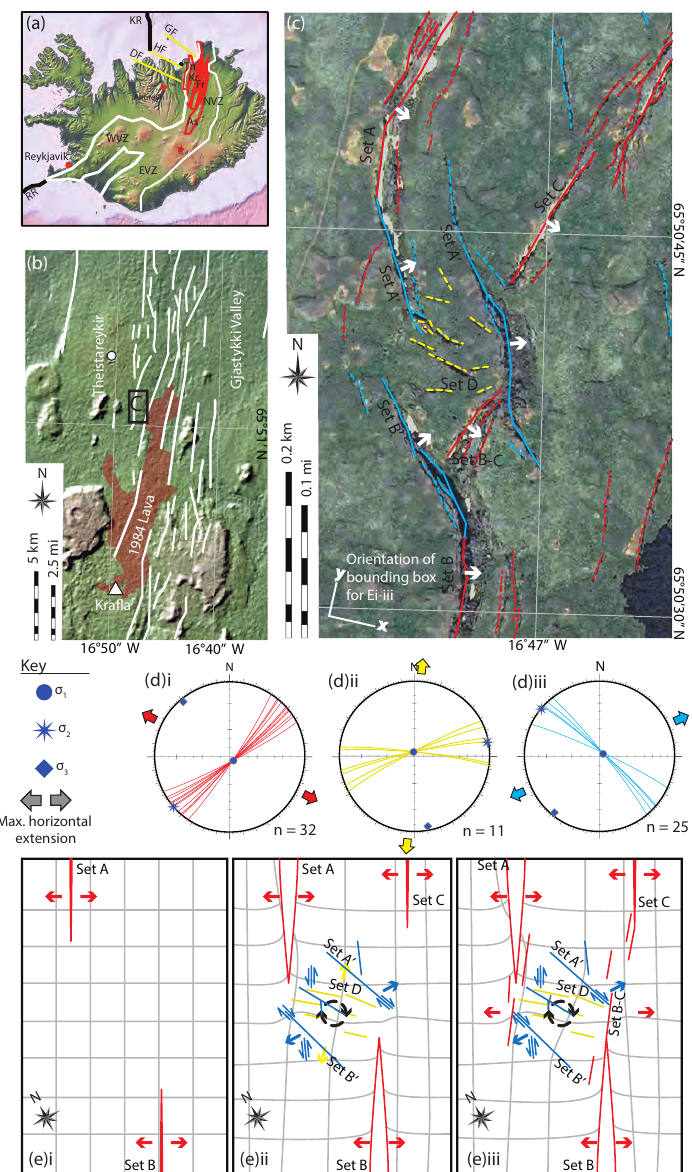
Figure 5. (a) Map of Iceland highlighting the major tectonic elements: Reykjanes Ridge (RR); the Kolbeinsey Ridge (KR); South Iceland Seismic Zone (SISZ); West Volcanic Zone (WVZ); East Volcanic Zone (EVZ); Neovolcanic Zone (NVZ: the axial rift zone); Askja volcanic centre (As); Fremri-Namur volcanic centre (Fr); Krafla volcanic centre (Kr); Theistareykir volcanic centre (Th); and the Tjörnes Fracture Zone (TFZ) comprising the Dalvík lineament (DF), the Húsavík-Flatey Fault (HF), and the Grimsey lineament (GF). (b) Location of study area in the Gjástykki valley within the Krafla fissure swarm. White arrows indicate dip direction for fault scarps in the area. (c) Mapped structures in the study area, colour-coded based on orientation and kinematics: (1) rift-zone-parallel faults and fractures (red); (2) rift-zone- oblique faults and fractures (blue); and (3) rift-zone-normal fractures (yellow). (d) Lower-hemisphere stereographic projections showing measured extension directions for each of the three structural sets. (e) Proposed schematic evolution of fault sets: (i) propagation of the main rift-fault sets A and B; (ii) interaction between sets A and B leads to a horizontal displacement deficit and vertical axis block rotation in the relay zone and induced local reorientation of extension direction accommodated on variably oriented ancillary faults and fractures; and (iii) continued propagation of the main rift faults (A, B, and C) leads to the development of new rift-parallel structures. The bounding box is aligned with first-order rift faults (sets A and